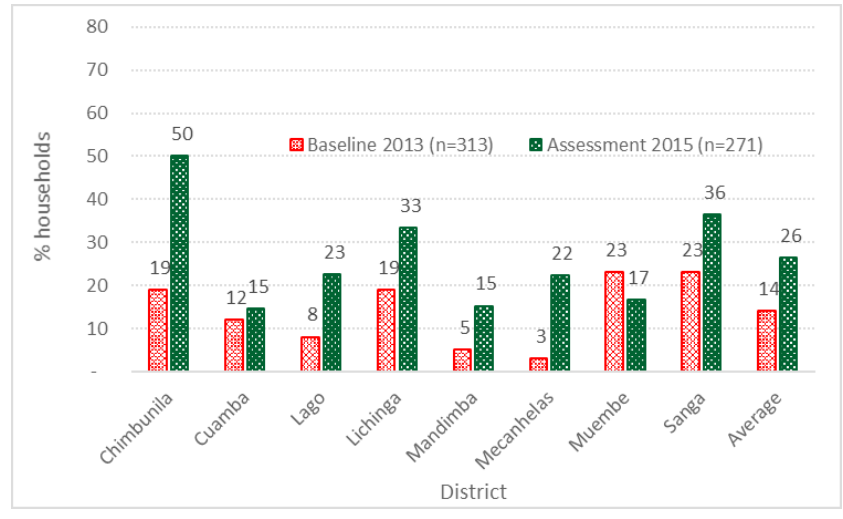
Figure 5: OFSP vine conservation at home